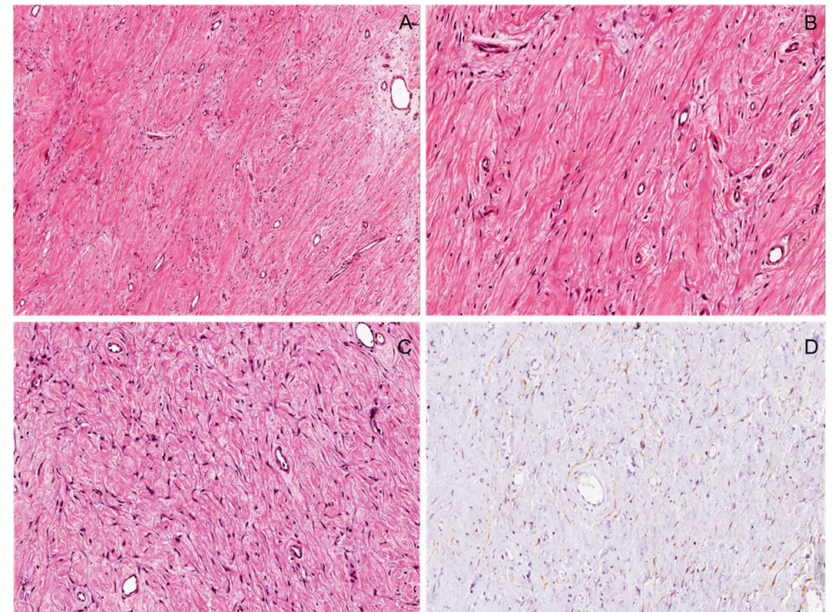
Figure 19. Sclerosing perineurioma. ( A ) Low-magnification image showing a hypocellular tumor composed of spindles set in a fibrosclerotic stroma. ( B ) Tumor cells are arranged in fascicular and/or reticular ( C ) growth patterns. ( D ) Neoplastic cells showing diffuse immunoreactivity for